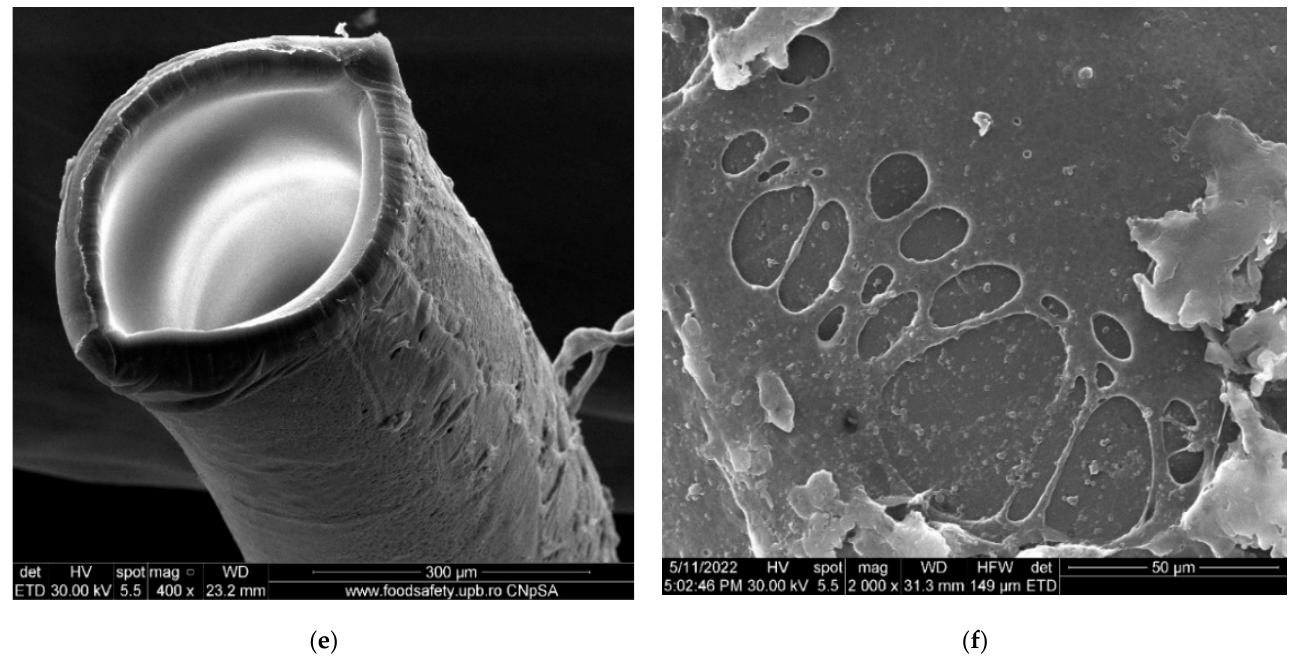
Figure 4. Scanning Electron Microscopy (SEM) on: ( a ) polypropylene hollow-fiber membrane (PPHF); ( b ) detail on surface; ( c ) sulfonated poly (ether ether ketone) (sPEEK)-polypropylene hollow fiber (sPEEK/PPHF); ( d ) detail on surface; ( e ) chitosan (Chi)–sulfonated poly (ether ether ketone) (sPEEK)–polypropylene hollow fiber (Chi/sPEEK/PPHF); ( f ) detail on surface.